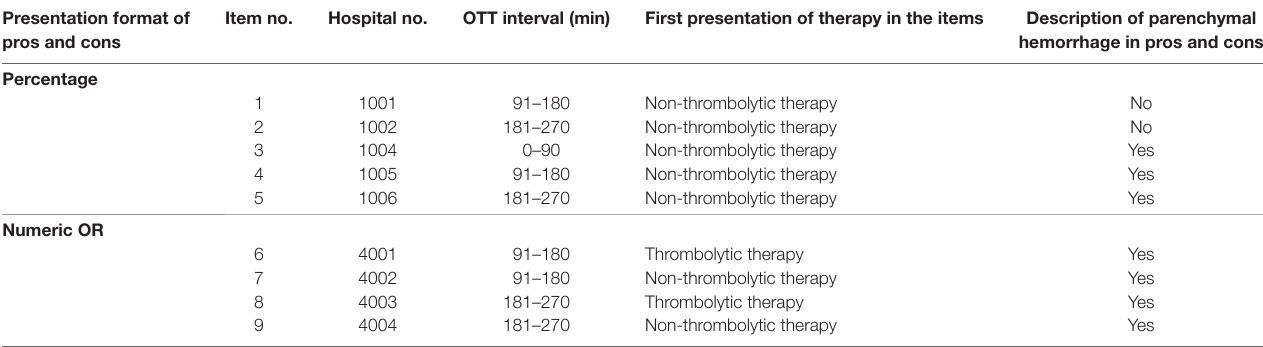
Table 1 | Formats of presentation of information related to thrombolytic therapy by different OTT intervals. Presentation format of pros and